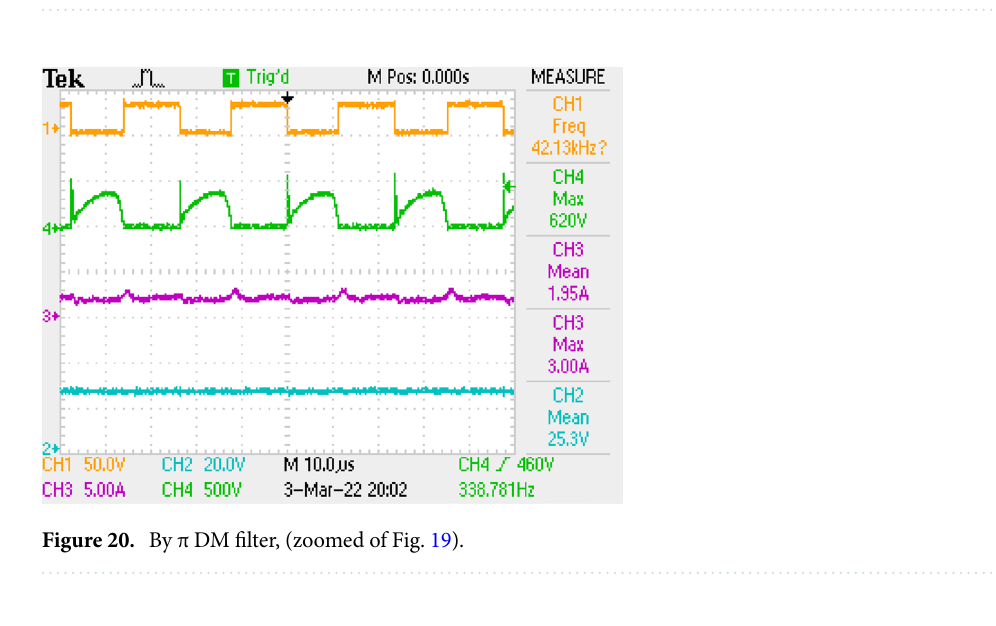
Figure 19. By π DM filter, PWM, voltage of switch, current–voltage of output.